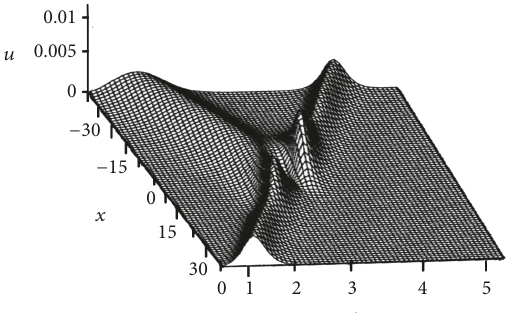
Figure 4: The shape of approximated solution 𝑢 app = 𝑢 3 in the pure fractional case ( 𝛾 = 0.80 ), plotted with respect to different fixed values of time and space at 𝑘 = 2.5 , 𝑑 = 4.0 , 𝜁 = 0.5. The motion is shown to behave irregularly compared to the conventional case and the dynamic tending to a chaotic one.